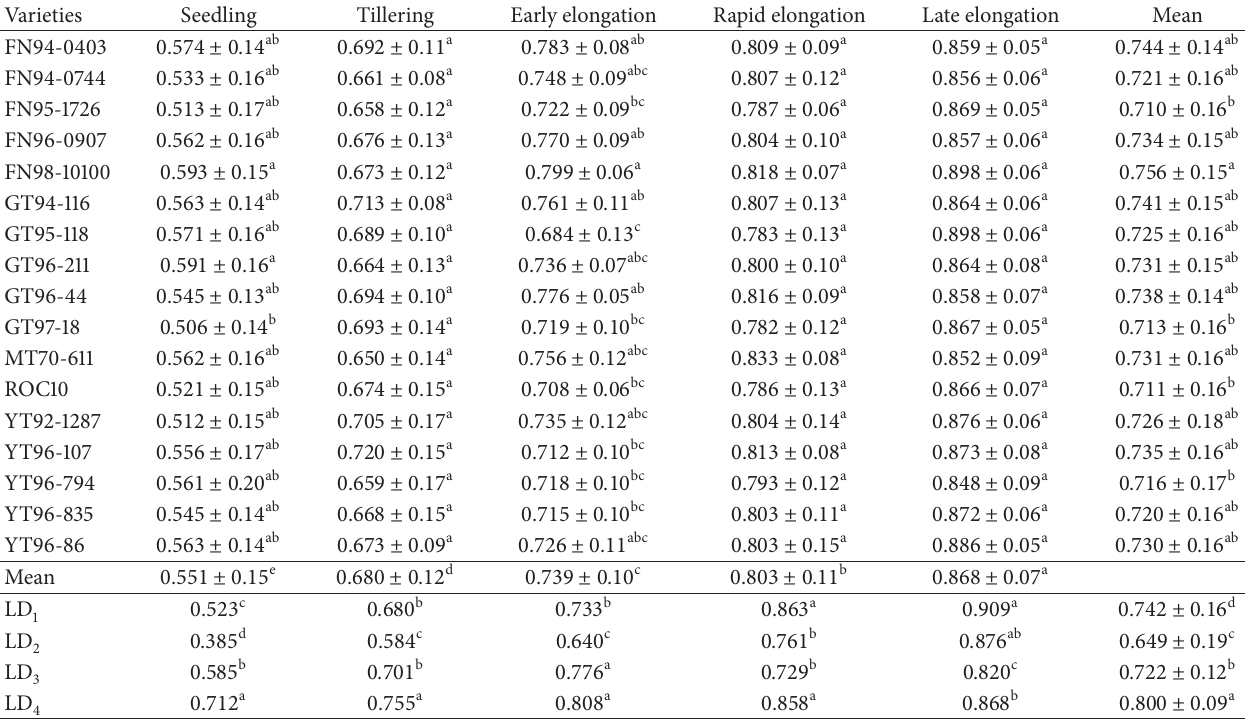
Table 6: Seasonal changes of leaf distribution in sugarcane